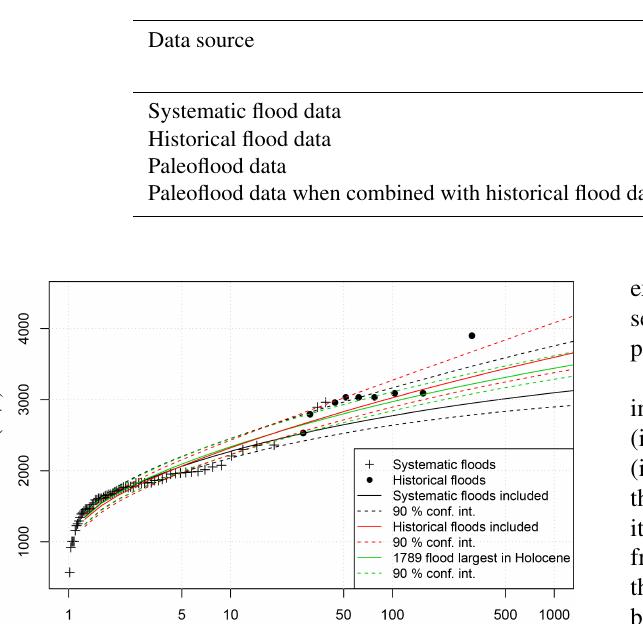
Table 6. Overview of the three data sources used for flood frequency analysis.